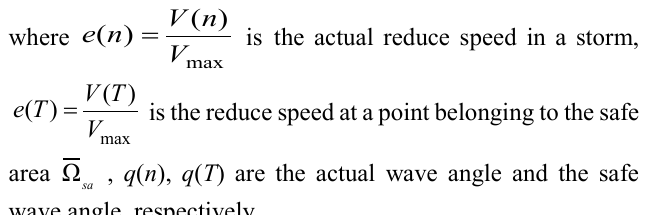
boundaries of the resonant zone Ω on the wave length λ in roll channel of the Ro-Ro passenger ferry 13. resonant zone Ω for wave length λ = 230 m . The outer circle corresponds to the reduced maximum speed of the vessel